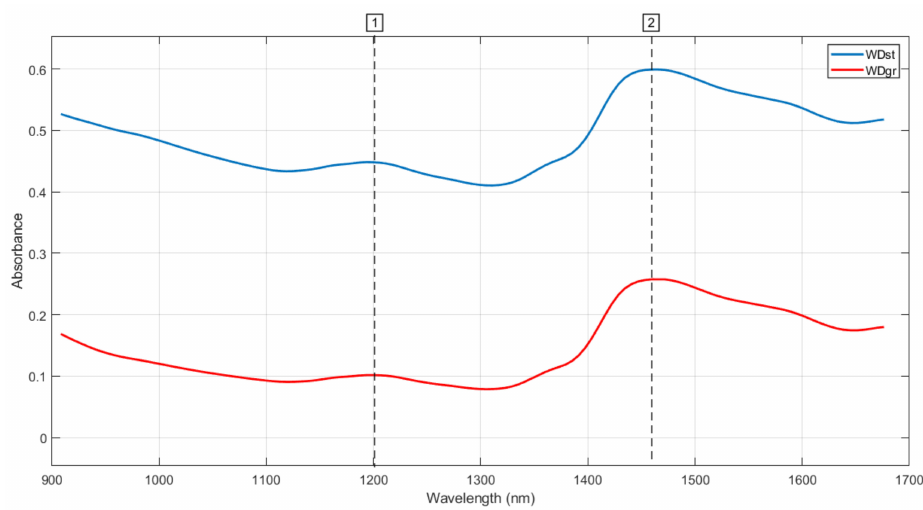
Figure 1. Average spectra of WD st samples (blue line) and WD gr samples (red line). The most important spectra peaks are highlighted with lines and corresponding numbers.